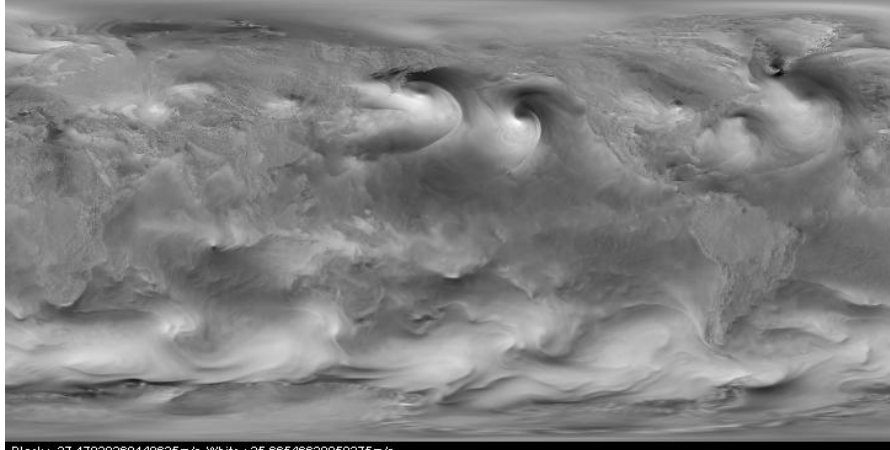
Figure 2. A typical wind field (world